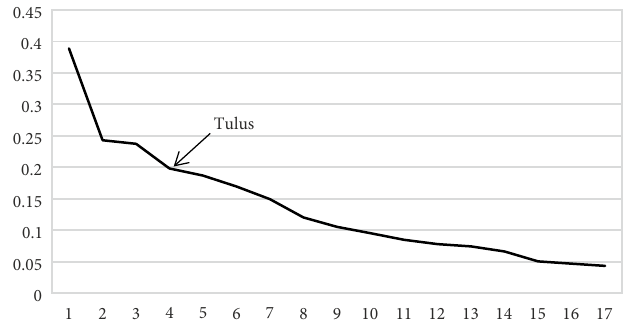
Figure 1. Eigenvalue chart (source: own elaboration based on Table 5)